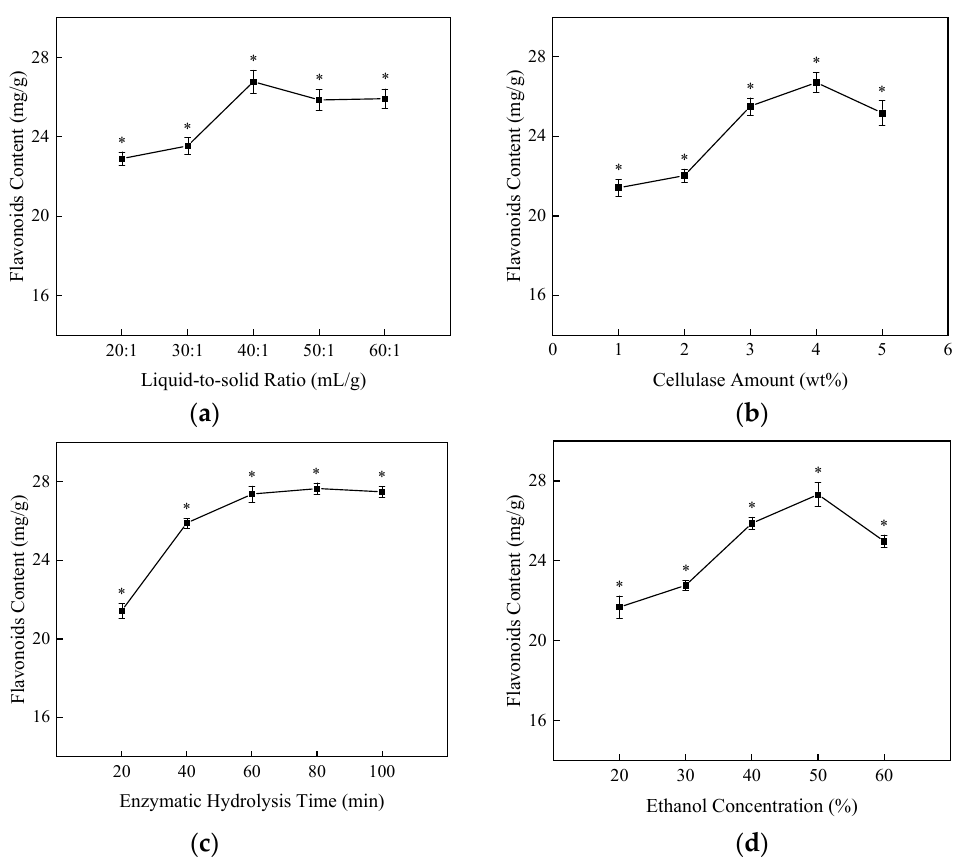
Figure 1. The influence of different factors on the content of flavonoids in NHE. ( a ) Liquid-to-solid ratio, ( b ) Cellulase amount (wt%), ( c ) Enzymatic hydrolysis time (min), ( d ) Ethanol concentration (%). The data shows as the mean ± S.D. ( n = 3). *: p < 0.05 compared between groups.